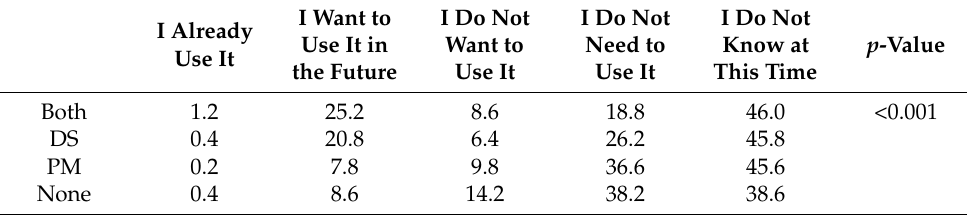
Table 10. Utilization of the Health Food Network consumer navigation site.